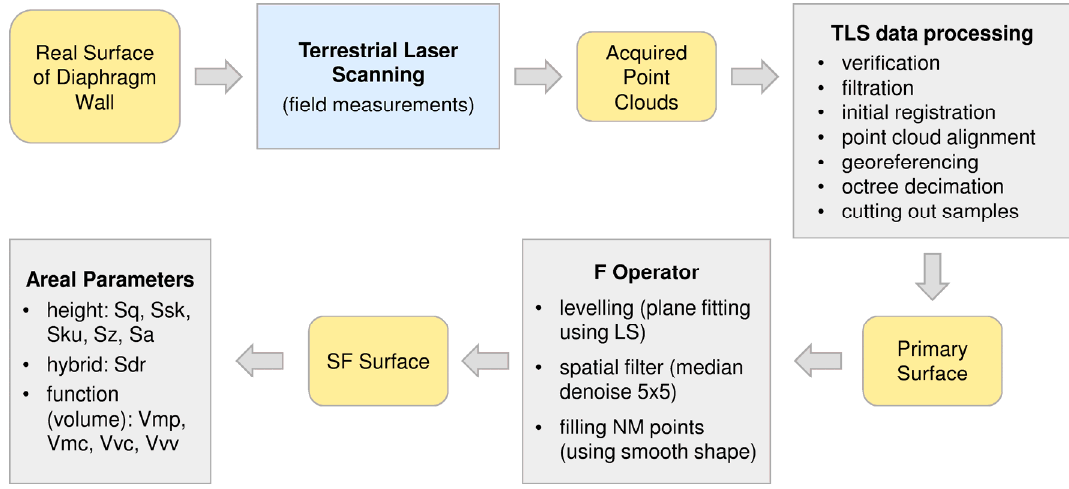
Figure 11. The procedure for the assessment of roughness of the diaphragm wall proposed by the authors.